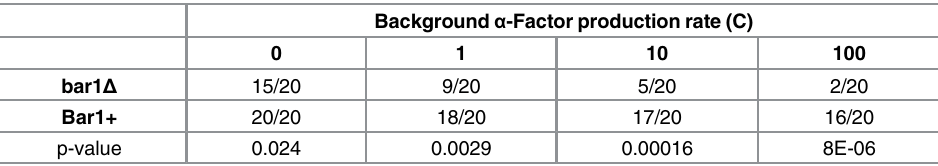
Table 1. Mating efficiency: Bar1+ versus bar1 Δ